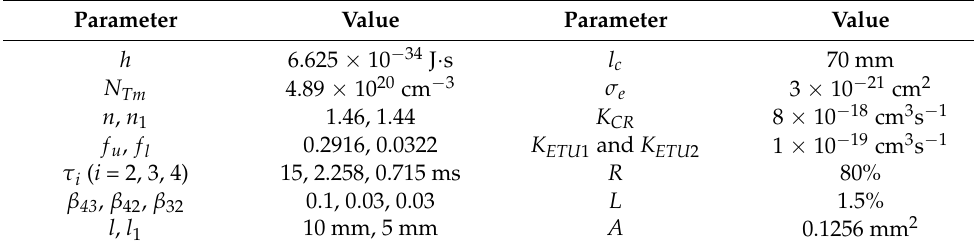
Table 1. Related parameters used in the numerical model [12–16]. Parameter Value